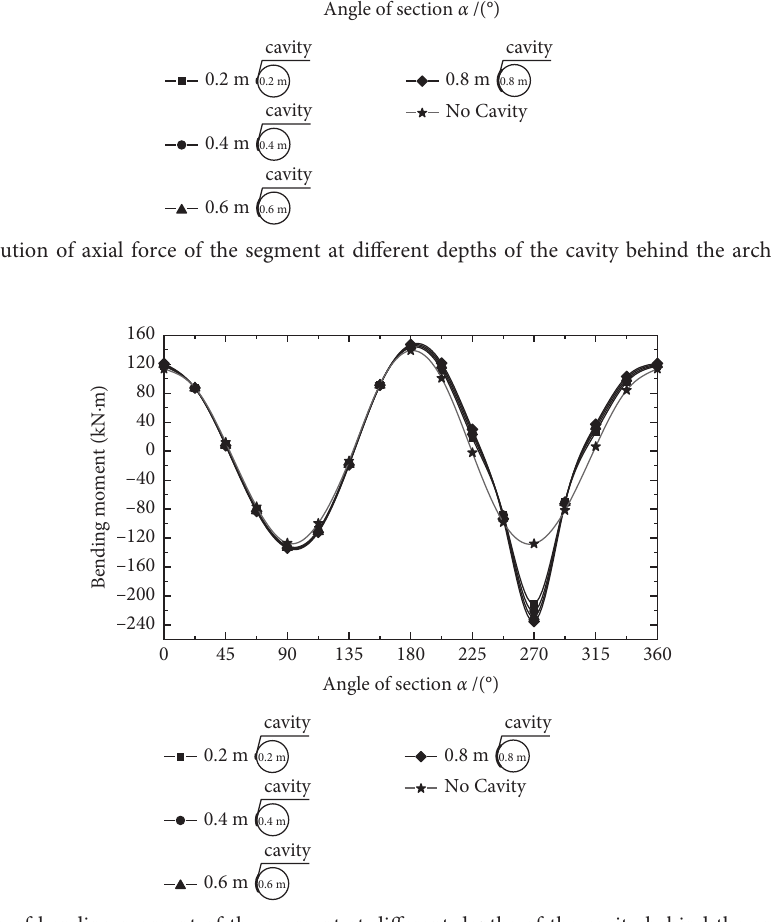
Figure 16: Distribution of bending moment of the segment at different depths of the cavity behind the arch waist (unit: kN ·